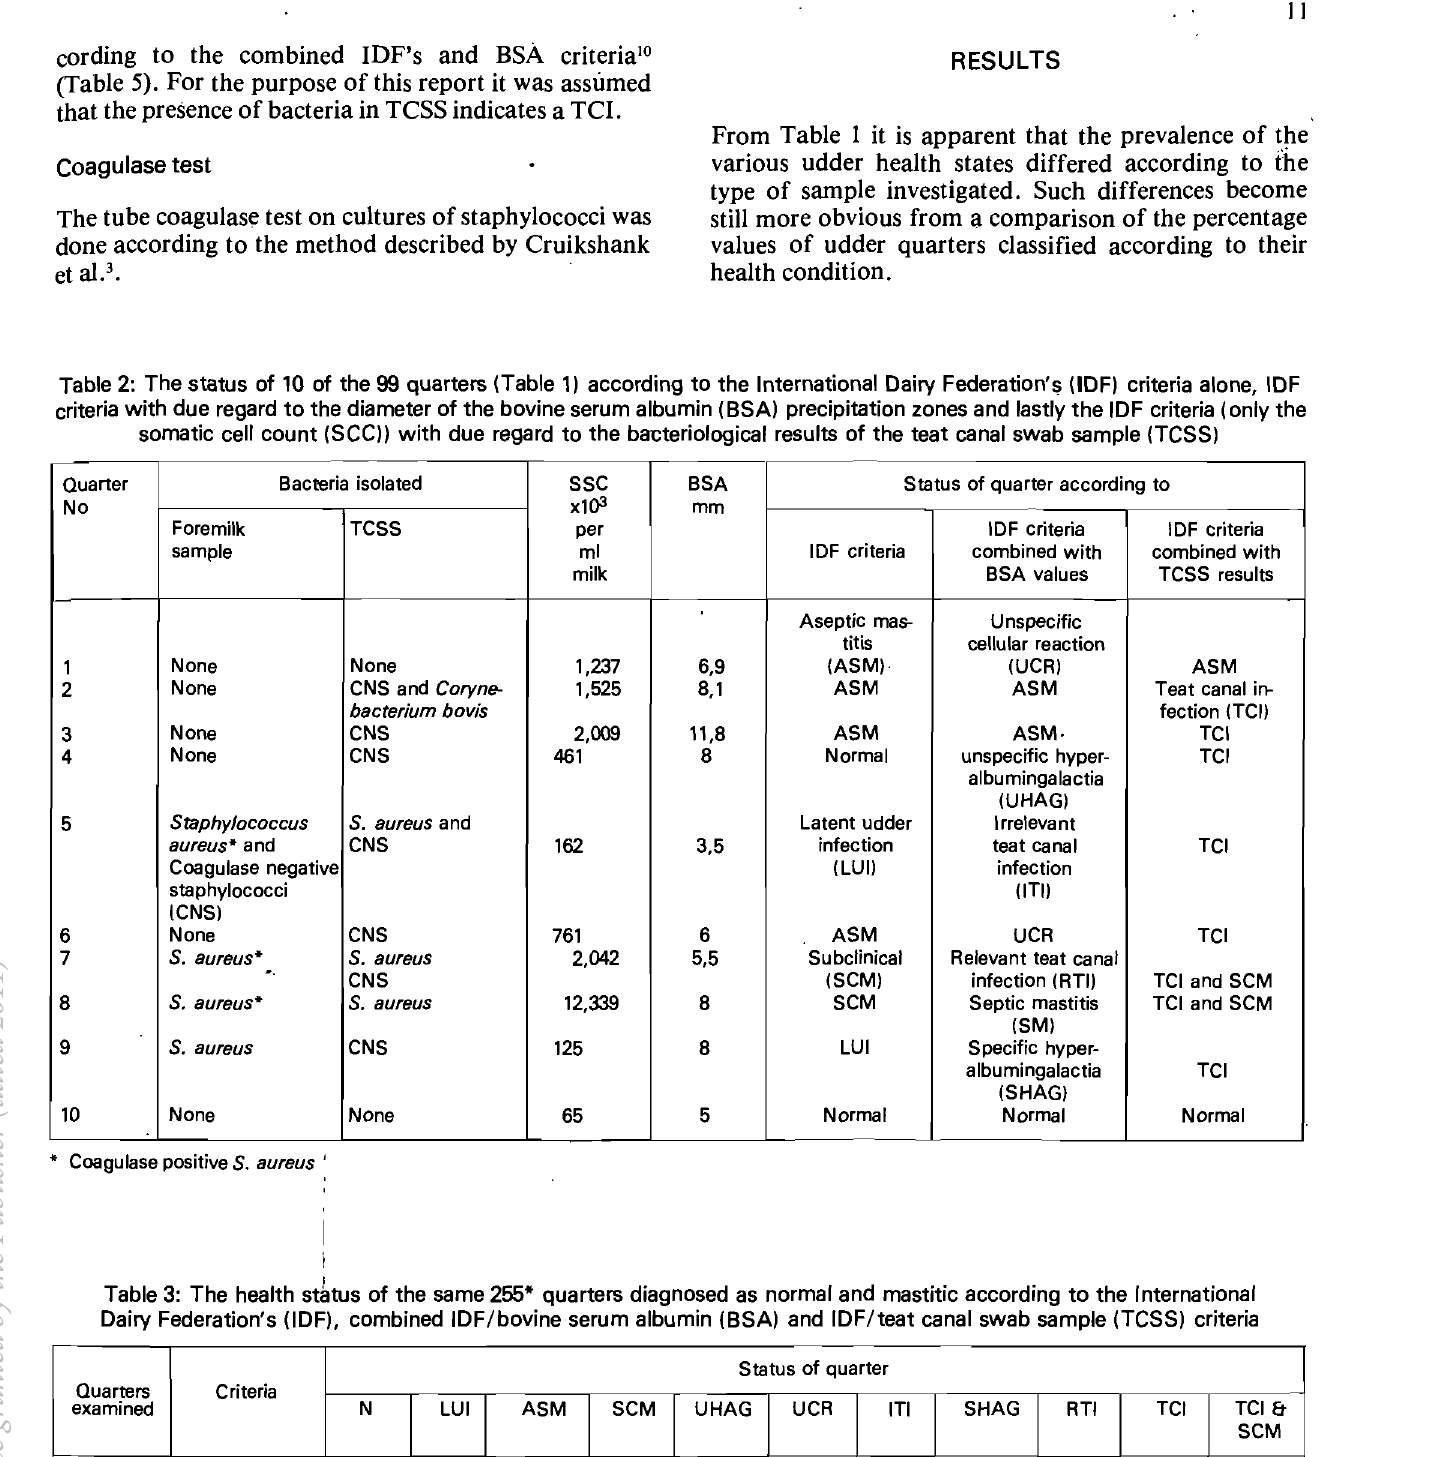
i I Table 3: The health status of the same 255* quarters diagnosed as normal and mastitic according to the International Dairy Federation's (IOF), combined IOF/bovine serum albumin (BSA) and IOF/teat canal swab sample (TeSS)